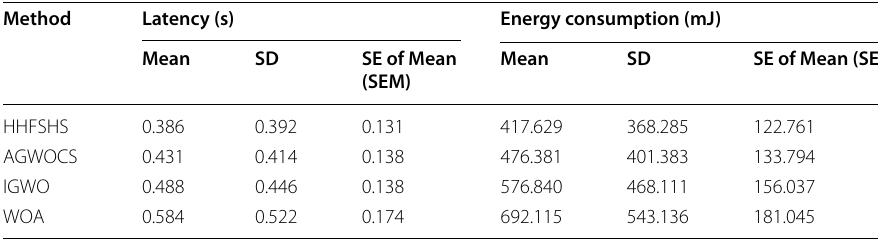
Table 3 Statistical analysis on latency and energy consumption